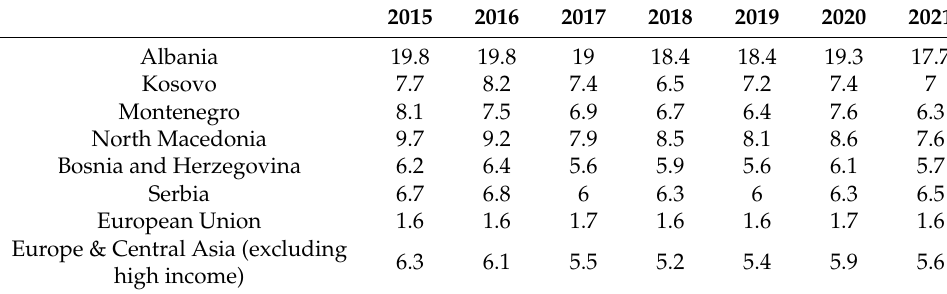
Table 2. Agriculture, forestry, and fishing, value added (% of